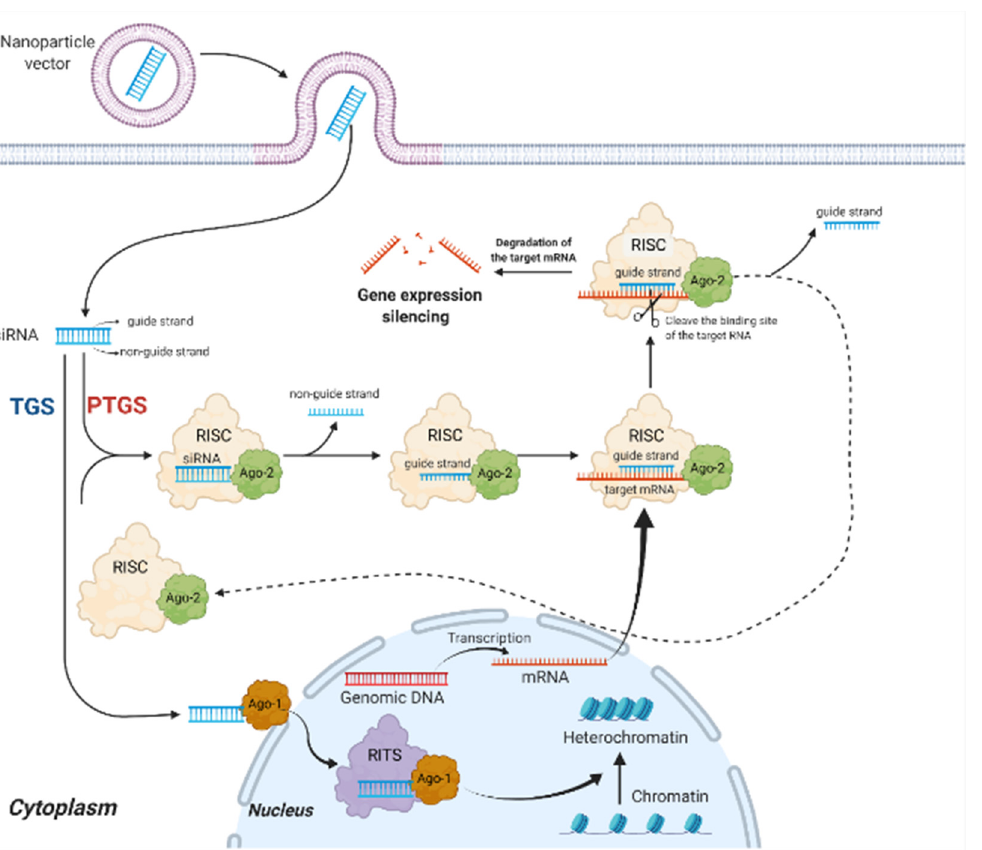
Figure 1. Mechanisms of siRNA therapy. PTGS primarily occurs in the cytoplasm. The guide strand binds to Ago-2 of RISC, while the non-guide strand is cleaved and ejected by the Ago-2; Ago-2 carries the guide strand to target mRNA, causing gene expression silencing. TGS has taken place in the nucleus. siRNA binds to Ago-1 on RITS, which contributes to the production of heterochromatin and induces the epigenetic silencing of the gene. PTGS, post-transcriptional gene silencing pathway; TGS, transcriptional gene silencing; Ago-1, Argonaute-1 protein; Ago-2, Argonaute-2 protein; RISC, RNA-induced silencing complex; RITS, RNA-induced transcriptional silencing complex. Created with BioRender.com.